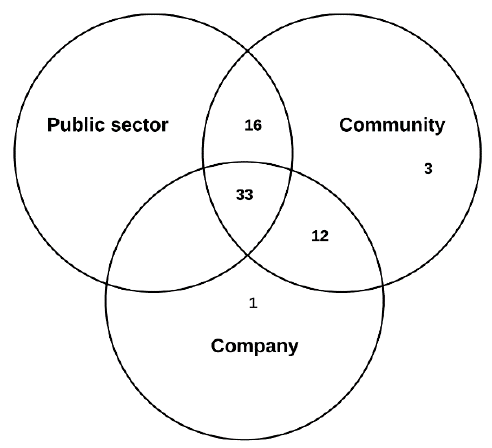
Figure 7. Venn diagram of the groups directly that benefit from the studies.